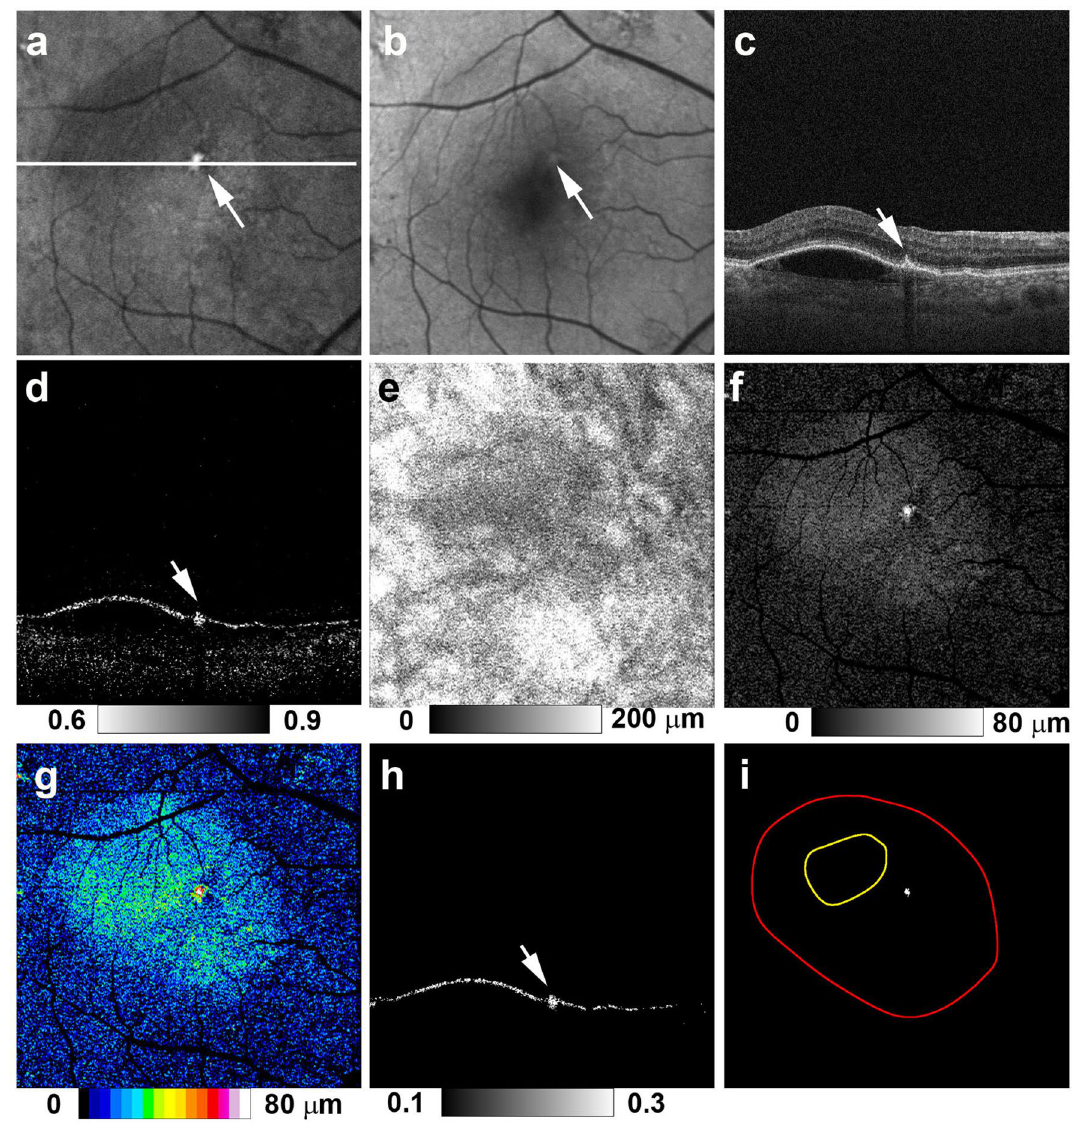
Figure 2. Multimodal imaging of serous PED in the right eye of a 70-year-old man. NIR-AF ( a ) and SW-AF ( b ) images show a hyper-AF lesion (arrows). The white line in image ( a ) designates the scanning line of the MC-OCT B-scan images ( c , d , h ). The standard OCT B-scan image ( c ) shows a thickened RPE band in the hyper NIR-AF lesion (arrow). The DOPU B-scan image ( d ) shows melanin accumulation at the RPE band (white arrow). RPE changes in the hyper-AF lesion are not evident in the chorioretinal melanin thickness map ( e ). The greyscale RPE-melanin thickness map ( f ) shows similarity with the NIR-AF image ( a ) and RPE-melanin thickness is readily visible in the color-coded RPE-melanin thickness map ( g ). RPE-melanin B-scan image ( h ) shows RPE-melanin accumulation at the RPE band (arrow). En face distribution of RPE 70 is shown in panel ( i ). Red line indicates the margin of the PED and yellow line indicates the axis position for 70% of the maximum PED height. The RPE 70 area in this patient was solely within the slope